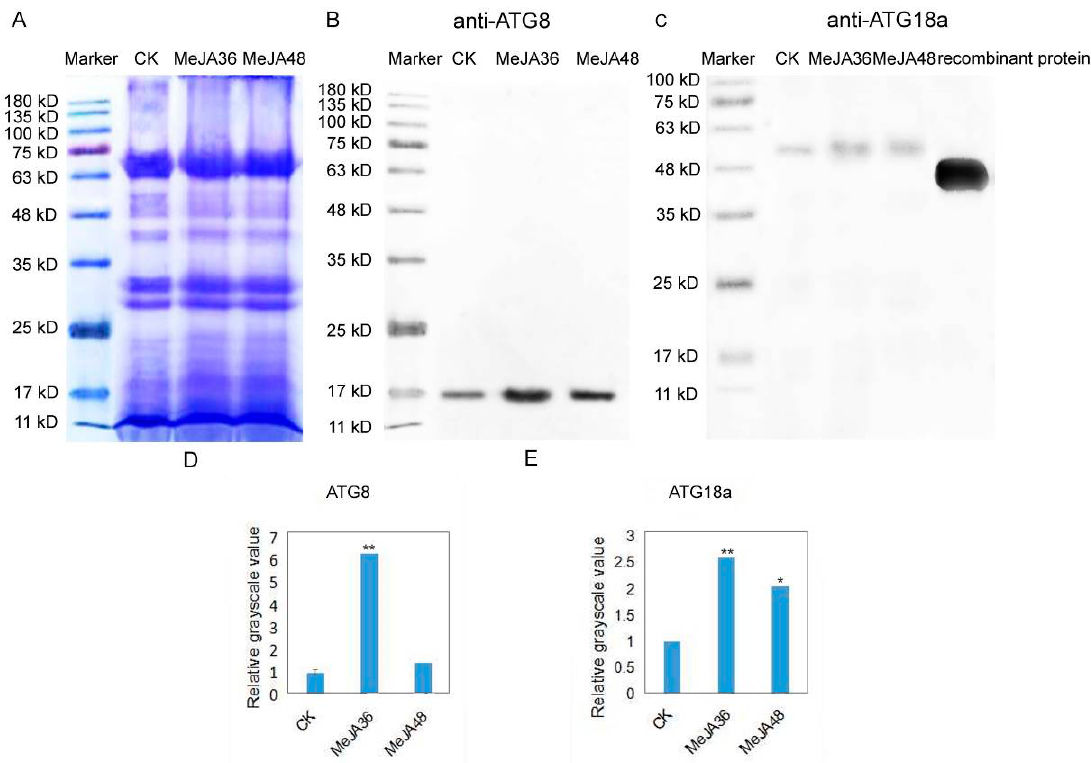
Figure 5. Western blot analysis of two autophagy related proteins in Euphorbia kansui laticifers of the control and MeJA treated groups. ( A ) Coomassie Brilliant Blue staining of the gel to show equal loading of proteins. ( B , C ) Western blot analysis of ATG8 and ATG18a. ( D , E ) Gray analysis of ( B , C ). “*” and “**” indicate statistically significant ( p -value ≤ 0.05 or p -value ≤ 0.01 versus control groups), measured by the Student t test.